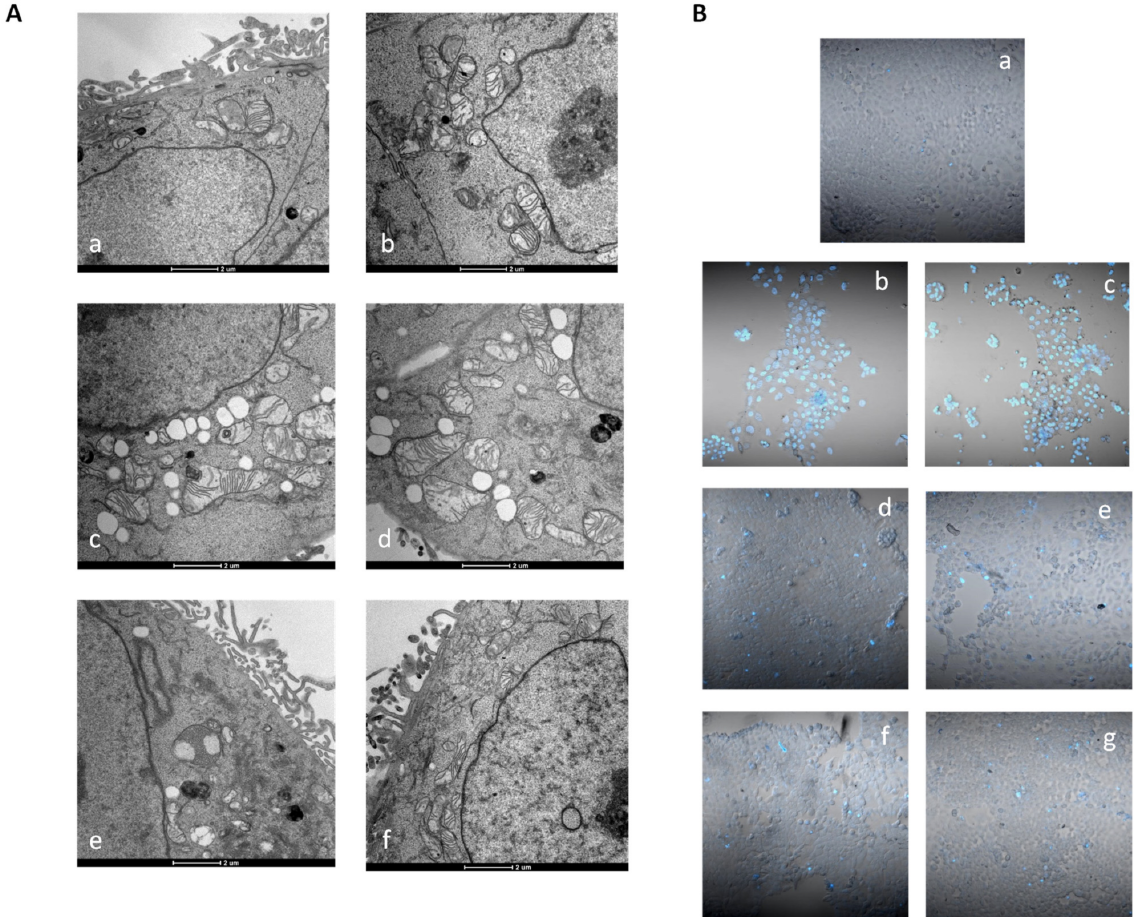
Figure 10. Morphological analysis ( A ) and cell death induction studies ( B ); ( A ) TEM analysis of HCT- 15 colon cancer cells: ( a , b ) control cells; ( c , d ) HCT-15 cells treated for 24 h with IC 50 concentrations of 4 ; ( e , f ) HCT-15 cells treated for 24 h with IC 50 concentrations of 8 ; ( B ) Hoechst staining of HCT-15 cells: ( a ) control cells; HCT-15 cells incubated for 24 or 48 h with IC 50 doses of 4 ( b , c ), 8 ( d , e ), or cisplatin ( f , g